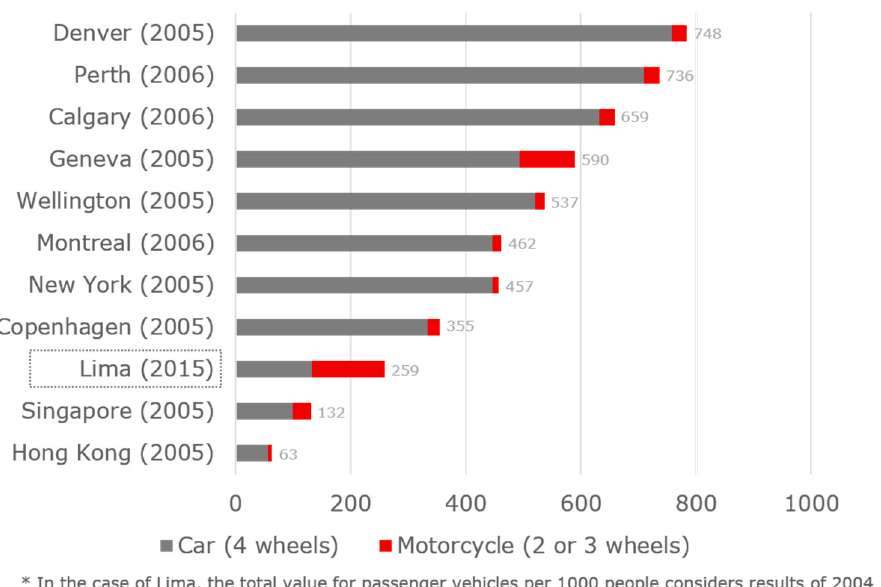
Figure 11. Private passenger vehicles per 1000 people (units / 1000 people). Source: References [34,47,57,63]. Graph by authors.